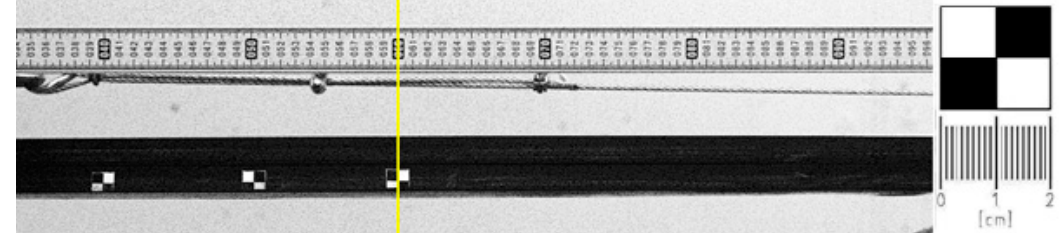
Figure 10. Image calibration—view of the belt with the measuring points and dimensions of the markers.